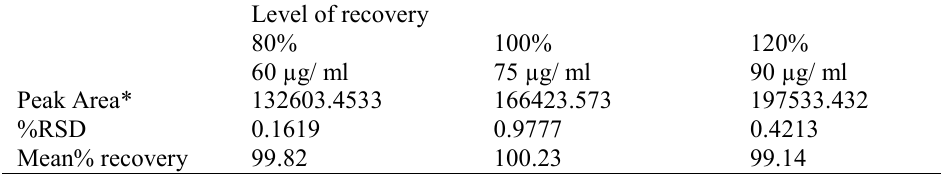
Table 4. Recovery studies of Aspirin Excepted